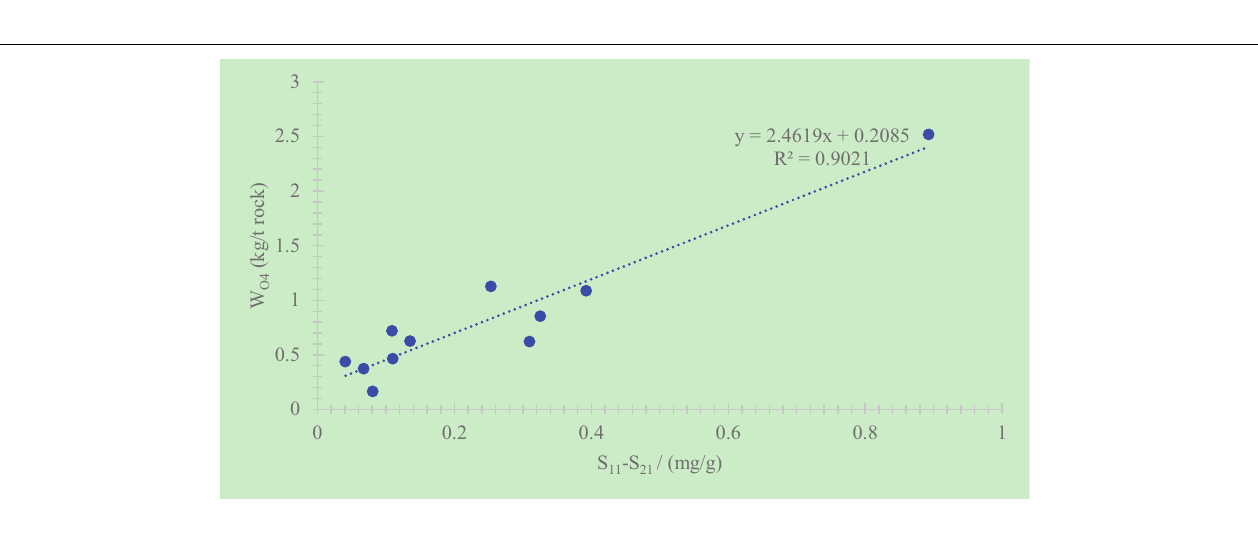
FIGURE 7 | Diagram between W O 4 and S 11 – S 21 . TABLE 3 | Calculation of oil content in organic-rich shale. Sample